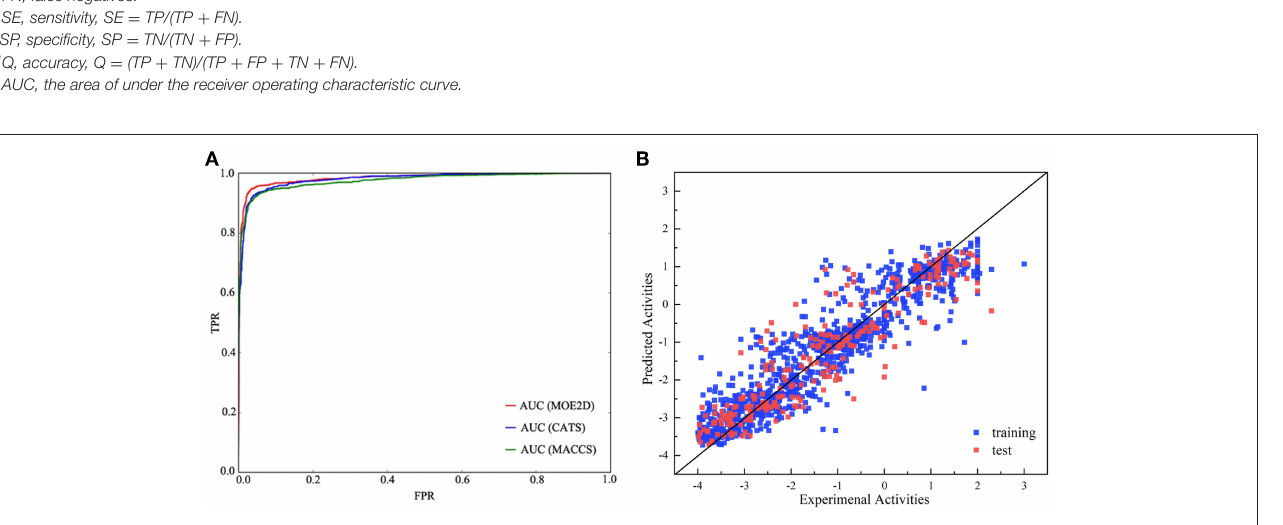
FIGURE 2 | The performance of different models. (A) Receiver operating characteristic (ROC) plot of RF classification models based on CATS, MACCS, and MOE2D descriptors for the test set. (B) Correlations between experimental and predicted activities of the training set (blue) and test set (red) of the RF regression model.